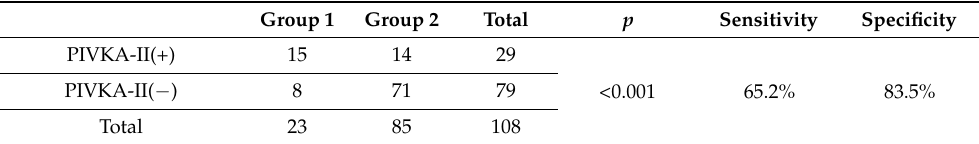
Table 4. The differential diagnostic value of PIVKA-II in CA19-9-negative